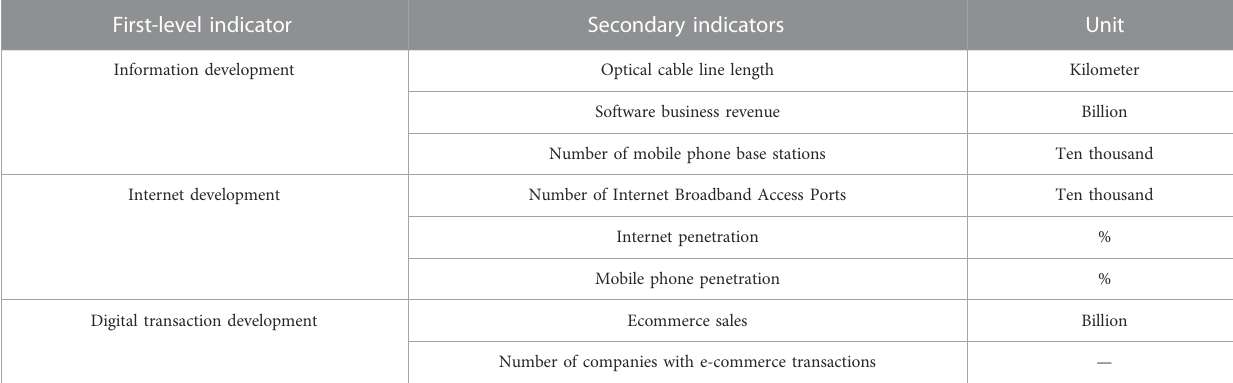
TABLE 1 Digital economy comprehensive development level indicator